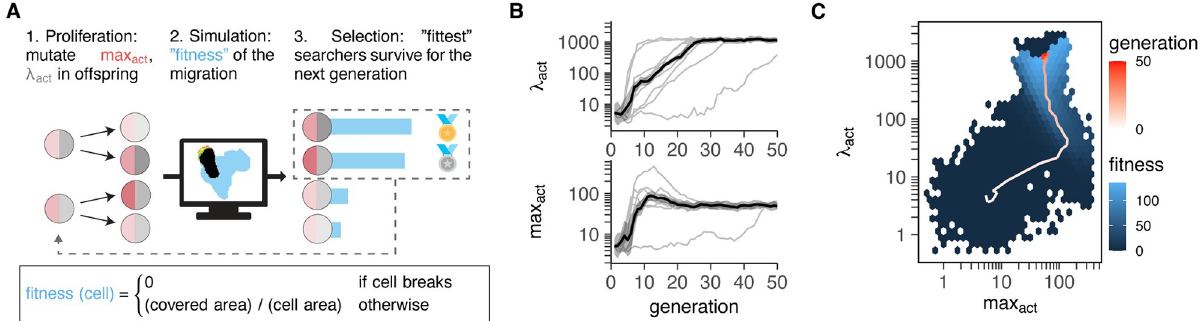
Fig 2. Evolution of optimal search behaviour in Act cells is subject to constraints and trade-offs. A: Simulated evolution in an evolutionary algorithm. A population of 10 Act cells with their own (max act , λ act ) parameters each produce three daughter cells with randomly “mutated” parameters (see Methods for details). After simulating migration for all 40 cells, only the 10 “fittest” cells (i.e. those that explored the largest area) survive as the next generation. Here, fitness is defined as the total area explored by the simulated cell during the simulation (normalized by the area of the cell itself). The fitness is zero if the cell breaks during the simulation. B: Evolution of λ act and max act over 50 generations. Black line + shaded area shows the mean ± SD within each generation. Thin gray lines show the same curve for 9 other, independent runs. C: Evolution of λ act and max act in the context of the median “fitness” experienced by cells with those parameters. The red trajectory represents one single run; the (blue) fitness landscape is constructed by averaging measured fitnesses from all cells of all (10) independent runs at given